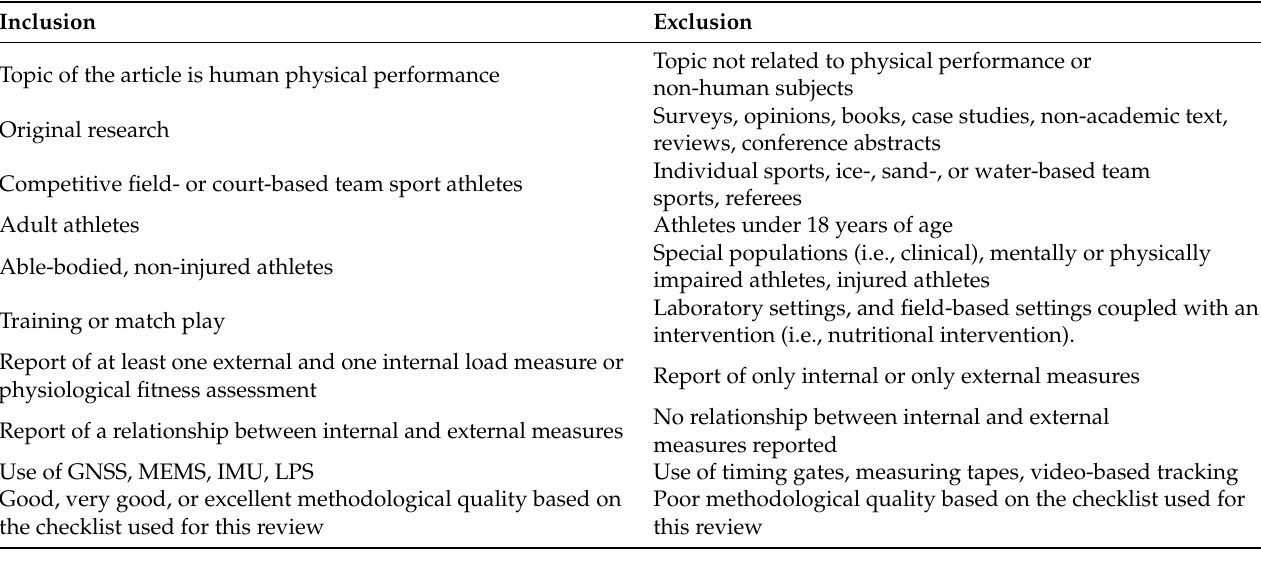
Figure 2. Flow diagram of the study selection process adopted from the PRISMA guidelines. Table 1. Search Term: Categories are connected with the Boolean operator “AND”; key words Table 2. Inclusion and exclusion within a category are connected with “OR”.